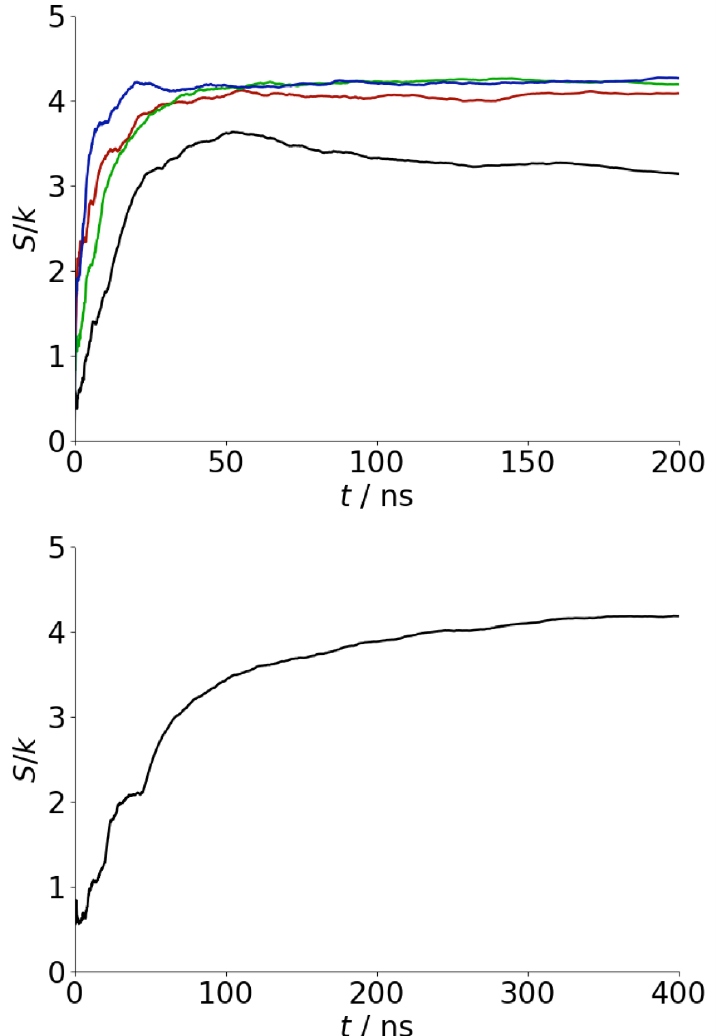
Figure A2. Variation in peptide conformational entropy with simulation time for surface (top ) and solution ( bottom ) simulations. For surface simulations black, red, green, and blue denote Au111, Au100, Ag111, and Ag100, respectively.